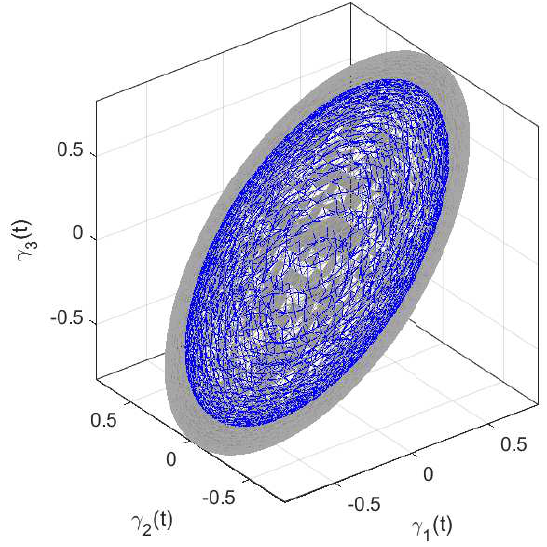
Figure 2. The allowable initial area (AIAs) based on Theorem 1 and Corollary 2 (method in [22,35]).